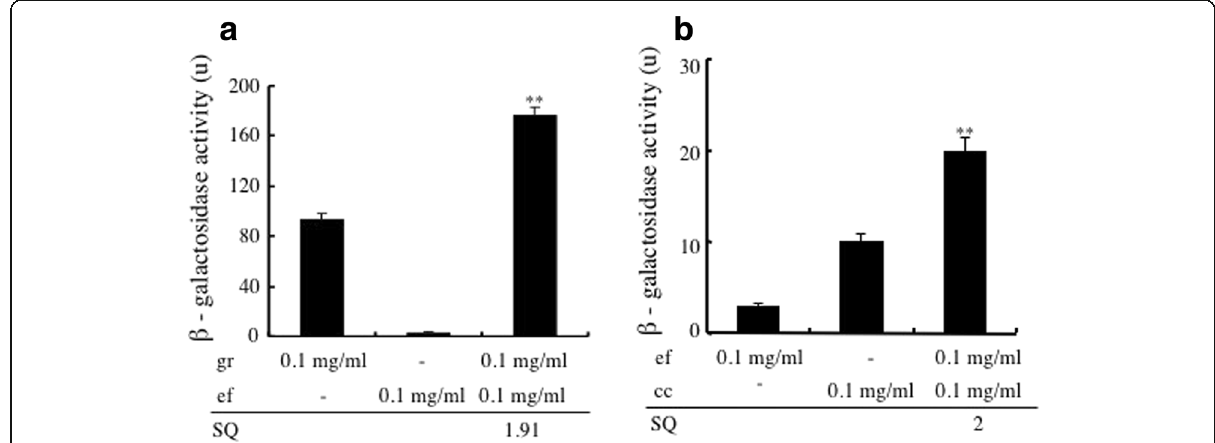
Fig. 4 Synergistic effects between the crude drugs found in UKT according to the yeast two-hybrid assay. a The synergistic effects of combining glycyrrhizae radix with other crude drugs on ER β -dependent estrogenic activity. b The synergistic effects of combining evodiae fructus with other crude drugs on ER β -dependent estrogenic activity. The β -galactosidase activity of the crude drugs alone and various pairs of crude drugs were evaluated at concentrations of 0.1 mg/ml (black columns). **significantly increased compared with the sum of the activity levels of the two crude drugs alone, p < 0.01. SQ values were calculated to determine whether each combination had synergistic effects, as described in the materials and methods. The data for the combinations that did not have significant synergistic effects in the yeast two-hybrid assay are not